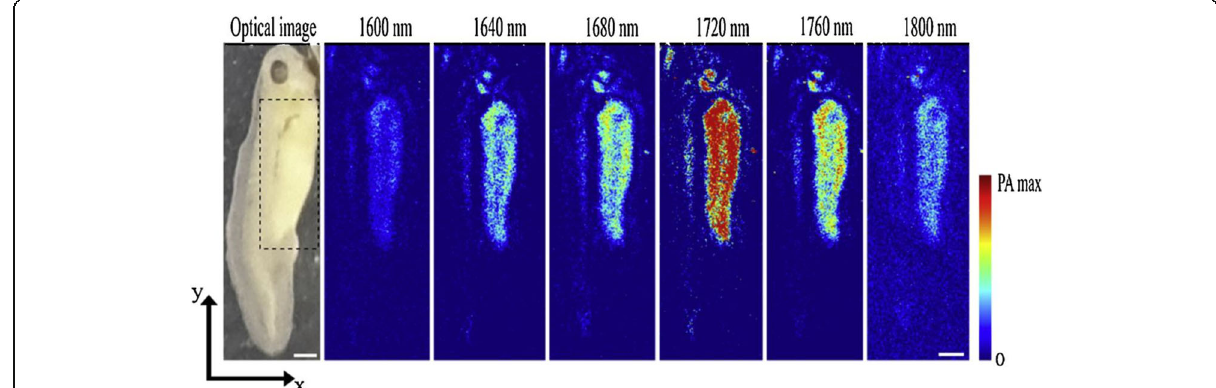
Fig. 4 Optical image and six in vivo PAM images of a Xenopus laevis tadpole acquired from 1600 to 1800 nm in steps of 40 nm. The highlighted region in the optical image shows the yolk sac. The scale bar represents 1 mm